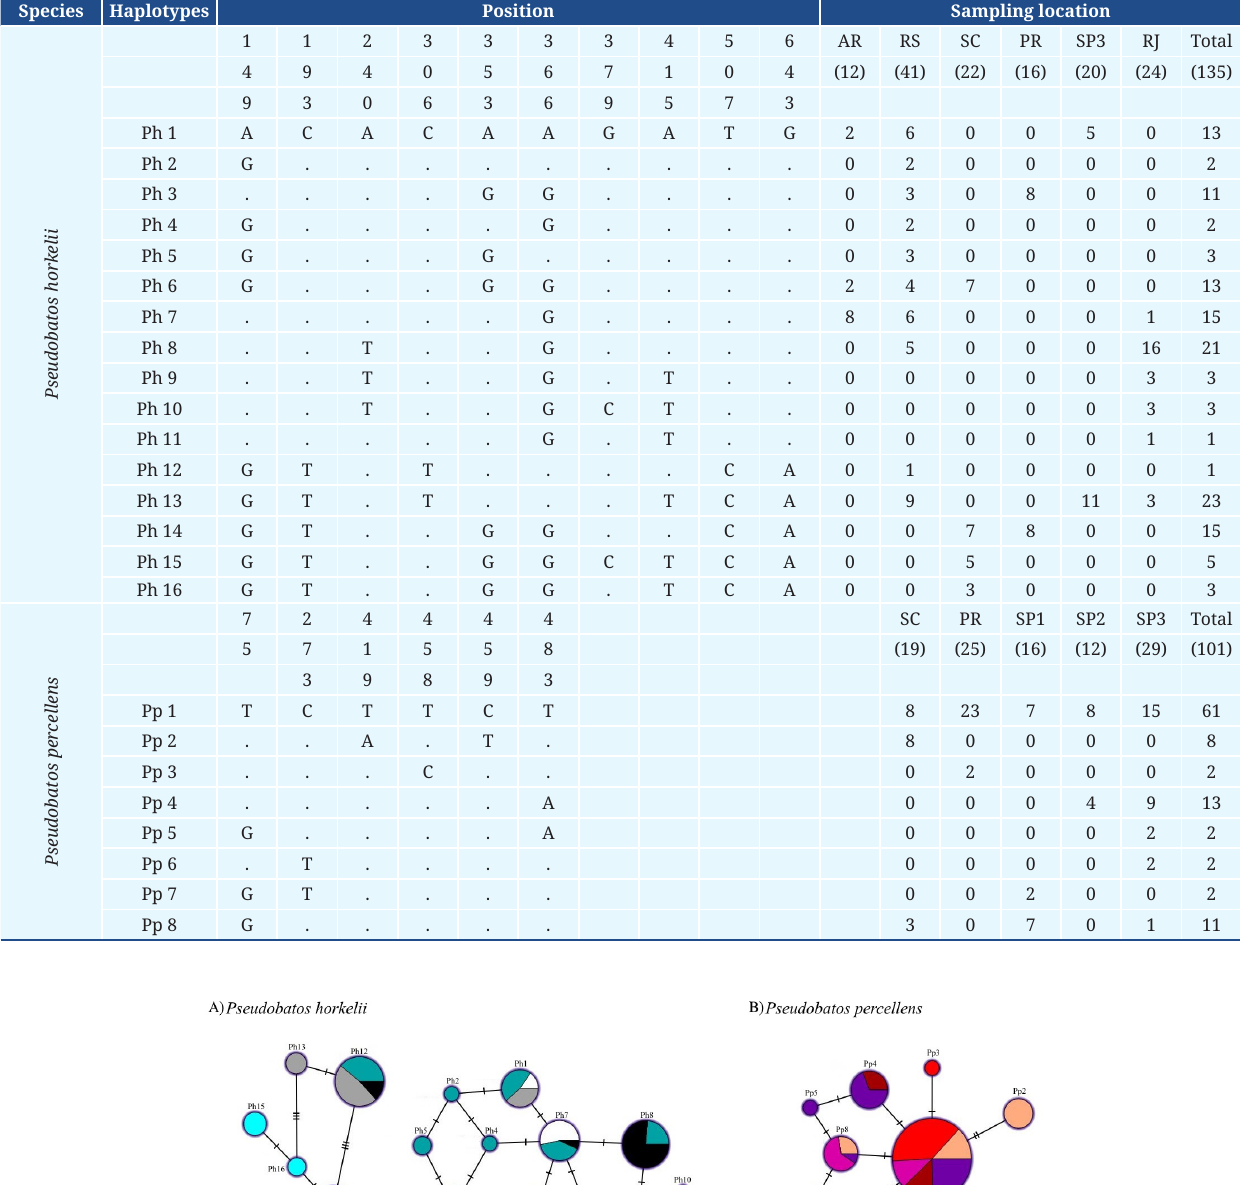
TABLE 1 | Polymorphisms and frequency found in haplotypes of Pseudobatos horkelii and P. percellens, based on D-loop. Regions of the North of Argentina coast and South-eastern / Southern regions of Brazil. AR – Argentina, RS – Rio Grande do Sul, SC – Santa Catarina, PR – Paraná, SP1 – Cananéia/SP, SP2 – Mongaguá/SP, SP3 – Santos /SP, RJ – Rio de